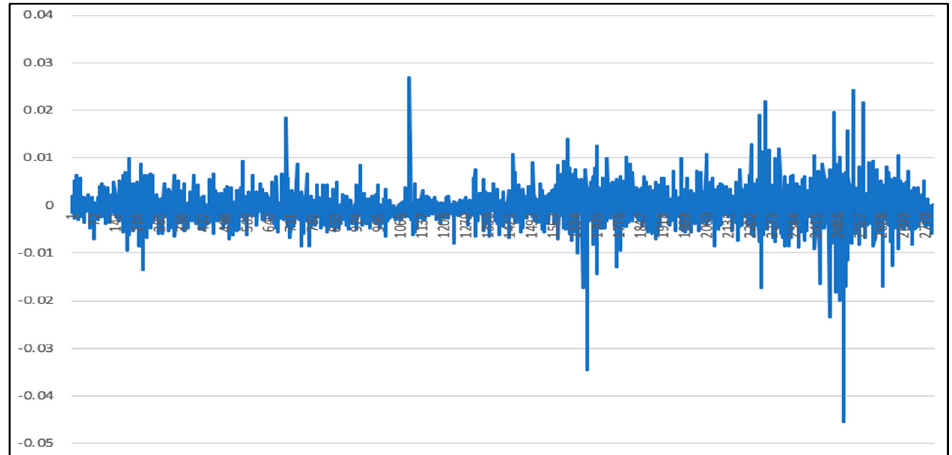
Figure 26. LSTM-SVR II prediction results and actual results error map (8500th data to 11,300th data).